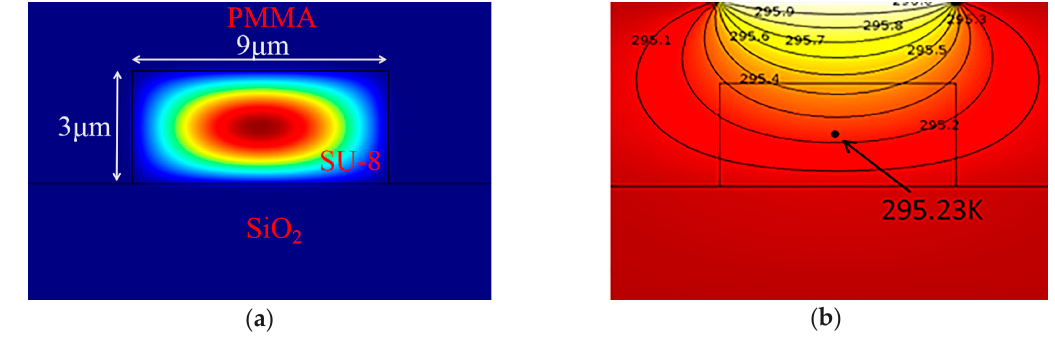
Figure 2. ( a ) The optical field of the fundamental mode in hybrid waveguide at 532 nm ( b ) the thermal field of the thermal optical switch.